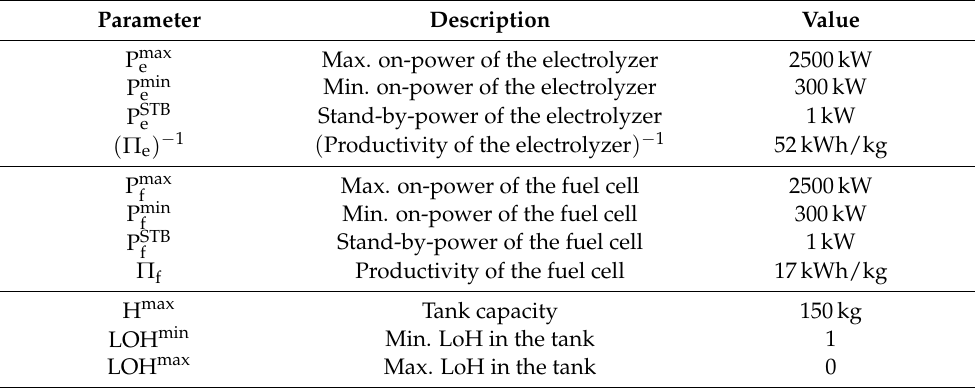
Table 2. Equipment’s relevant